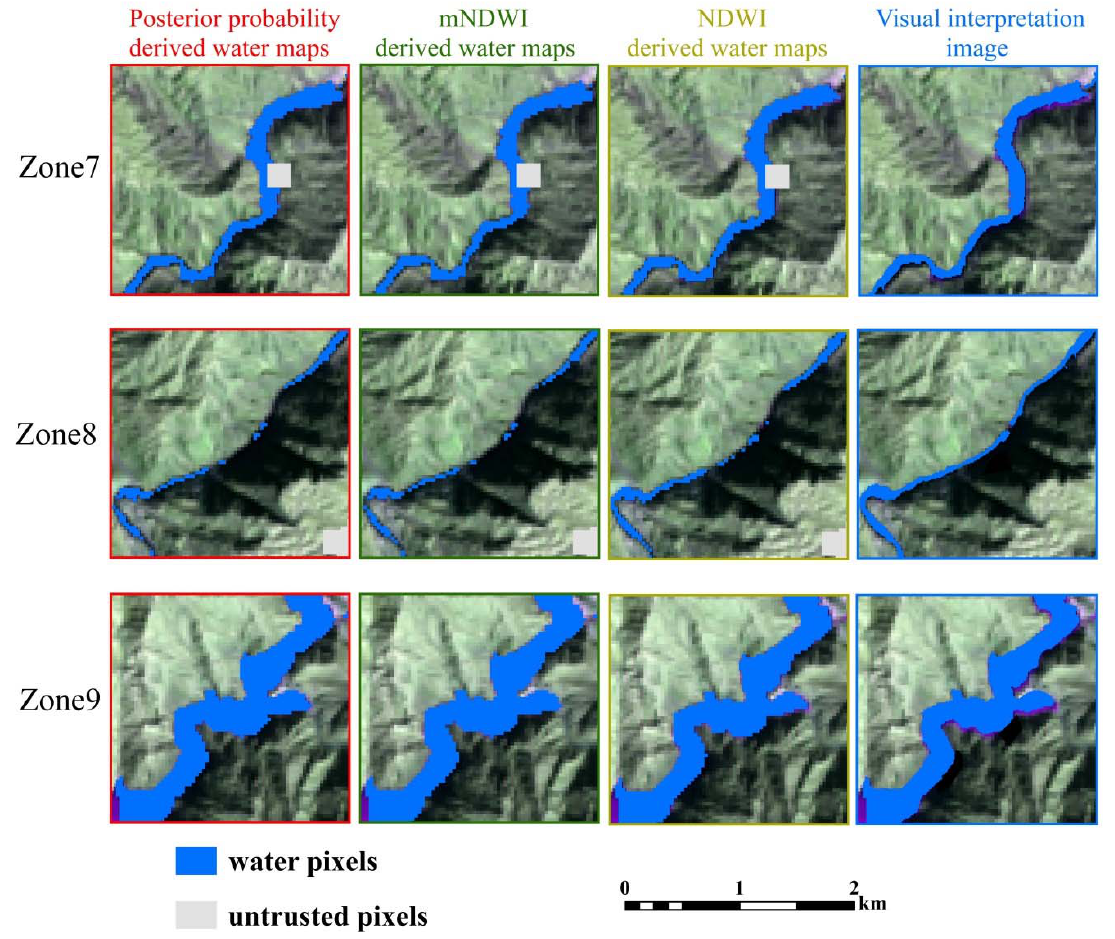
Figure 12. Binary water maps derived from posterior probability, mNDWI, NDWI, and Sentinel-2 visual interpreted for three demonstration zones in the Yingluoxia reach. Table 5. Accuracy indices of three water maps derived from different methods for the Yingluoxia Reach.